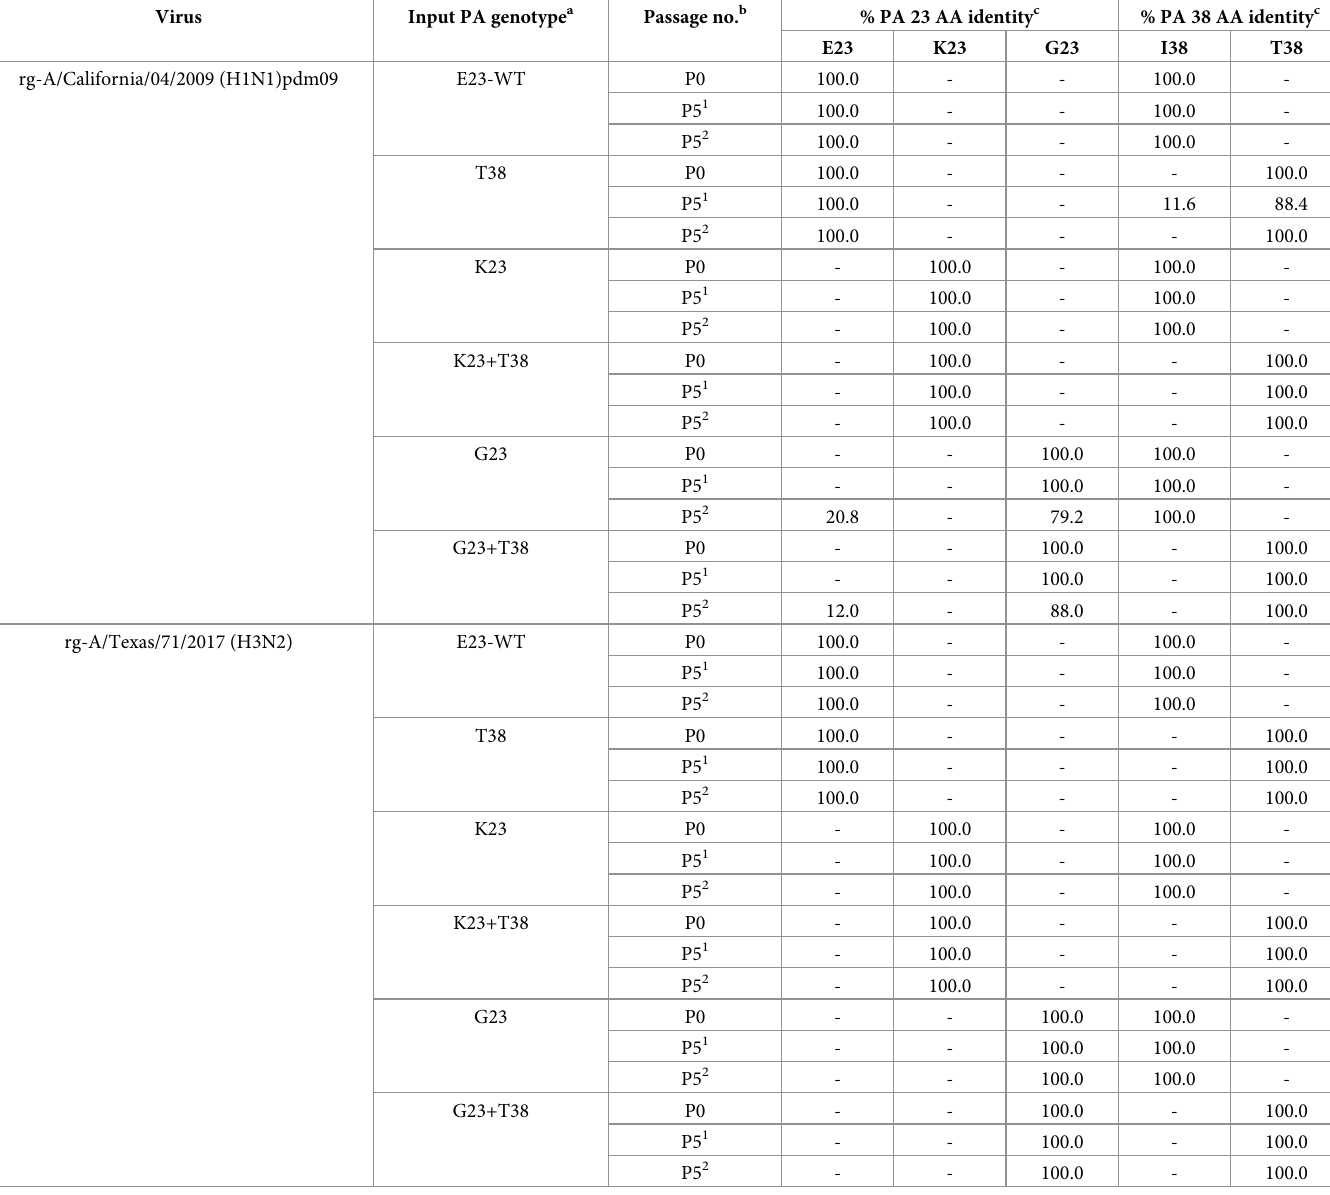
Table 2. Genotype stability of influenza A(H1N1)pdm09 and A(H3N2) viruses passaged in the absence of baloxavir.